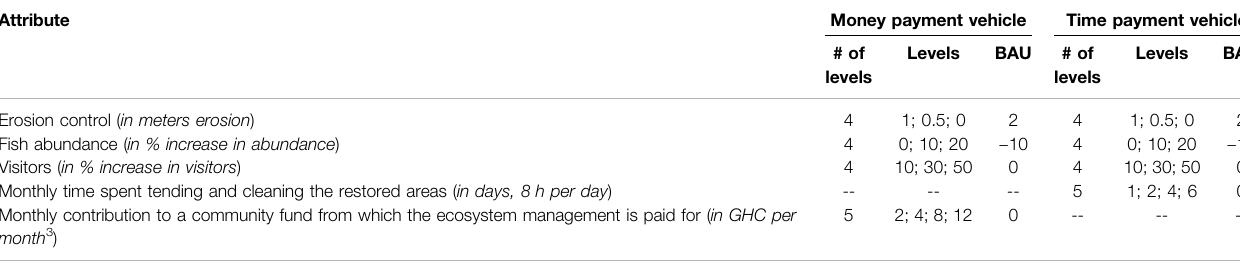
TABLE 1 | Attributes and attribute levels for the discrete choice experiments (one for each payment vehicle)